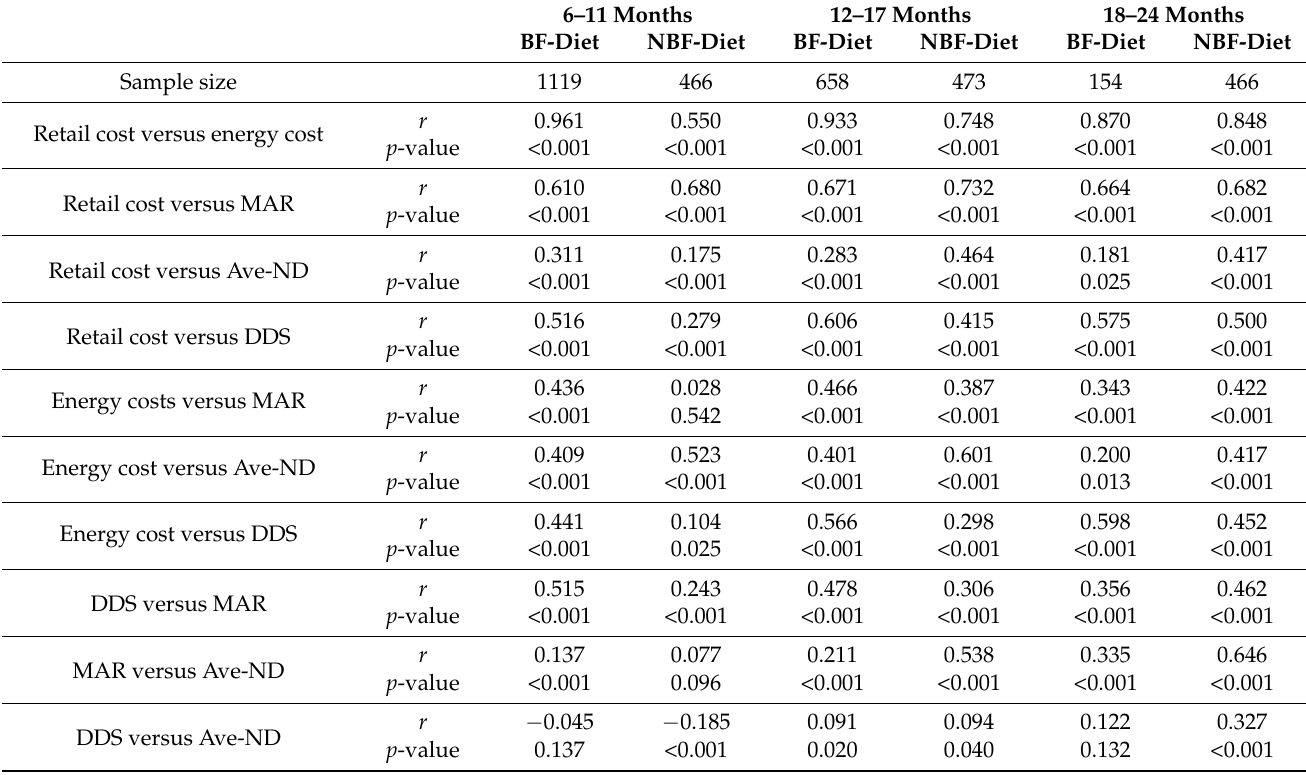
Table 3. Spearman correlation coefficients for diet cost and diet